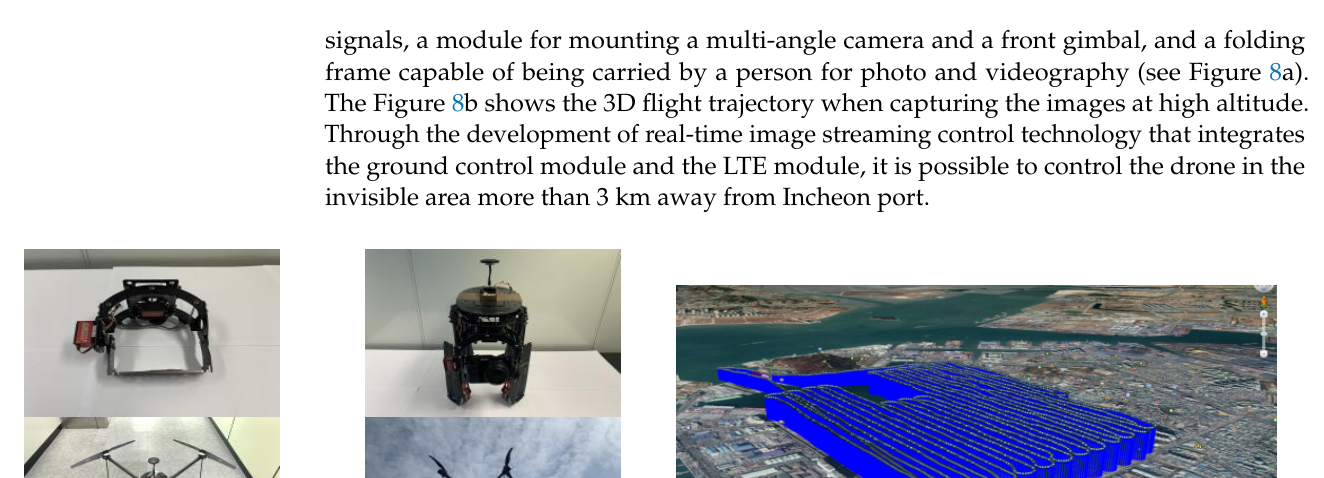
Figure 8. Experimental setup with ( a ) a drone with a front gimbal and its ( b ) flight trajectories at Incheon port. Figure 9. Estimation of the relative displacement using port structure images.